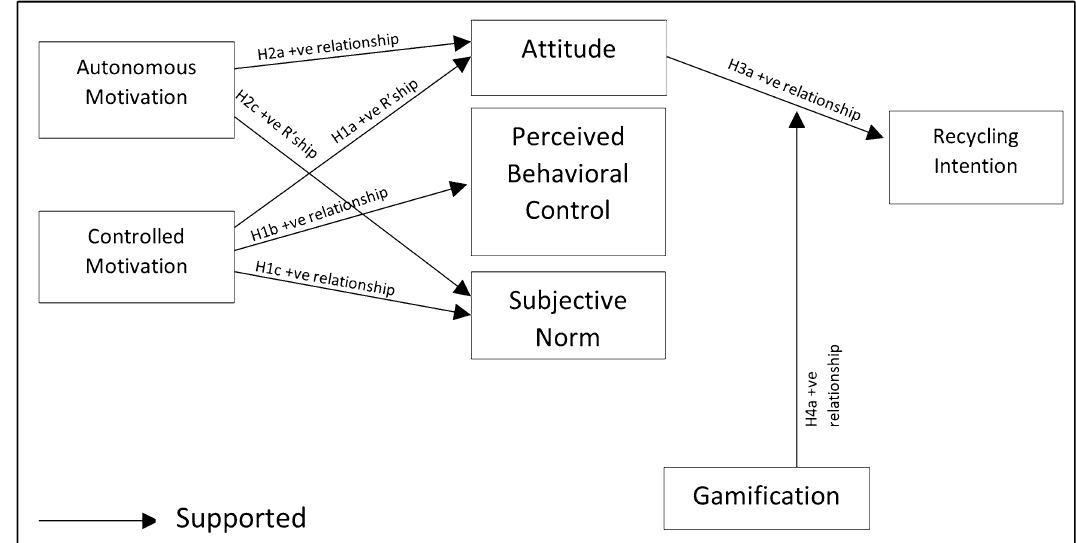
Figure 4. Verified conceptual model of motivation and recycling intention on gamified